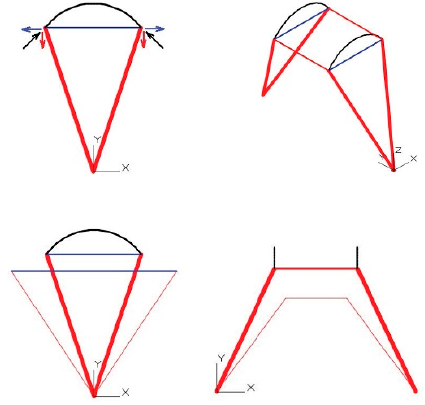
Figure 4. Diagram of functionality of the longitudinal arch thrust.